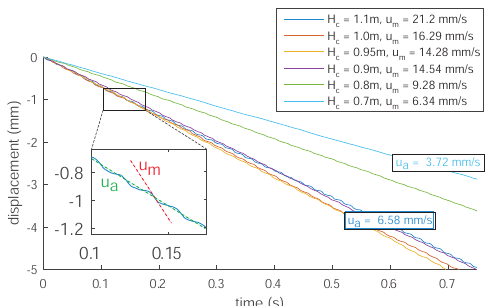
Figure 3. Average particle motion, velocity, and acceleration for ballotini particles in a glass tube at H c = 1.1m. Each slip is around 0.05mm, with velocities reaching 10 − 3 ms − 1 , and deceler- ation around g .